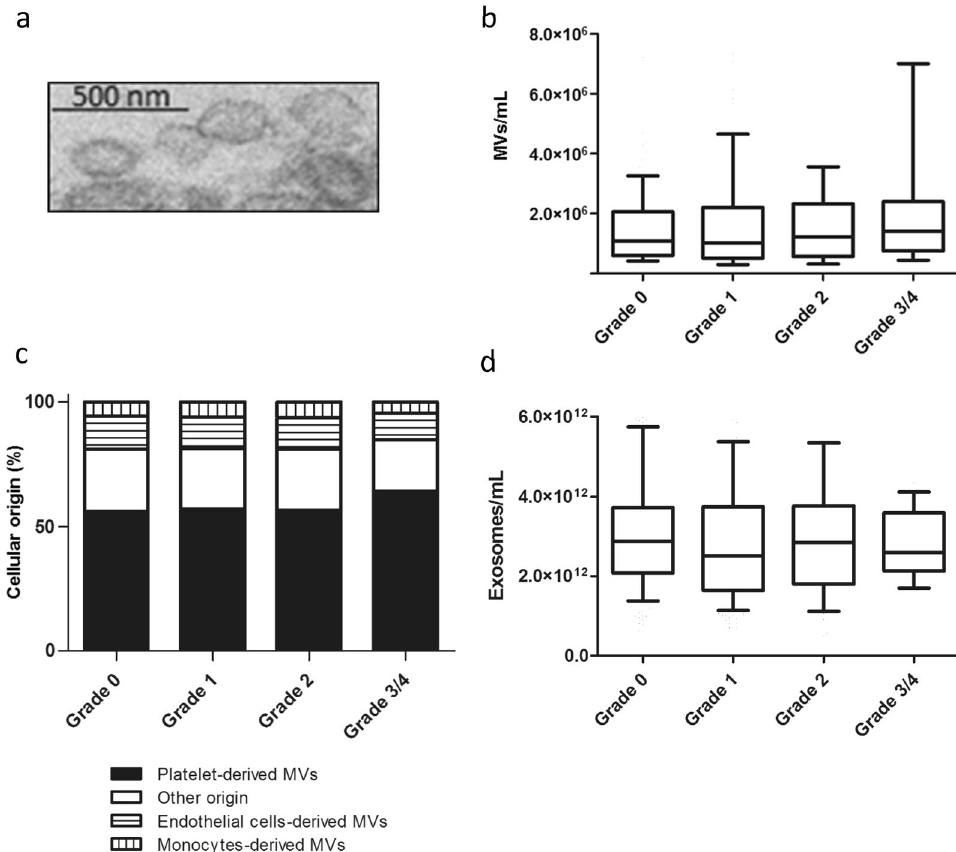
Figure 2. Circulating EV characterization in patients. ( a ) Morphology of circulating EVs isolated from grade 0 patients by transmission electron microscopy. Scale bars: 500 nm. ( b ) Levels of circulating MVs in patients, according to their RB grade. MVs were enumerated after labeling with Annexin V using flow cytometry. ( c ) Cellular origin of all enumerated MVs. Data are expressed as percentage of MPs enumerated in ( b ). ( d ) Levels of circulating exosomes. Exosomes were enumerated using NTA technology with Nanosight. Data information: In ( b , d ) data are presented as median (horizontal bar), 25th and 75th percentile (boxes), and 10th and 90th percentile (error bar). EV levels were analyzed by ANOVA followed by Dunn’s multiple comparison test. Results with a P -value < 0.05 were considered